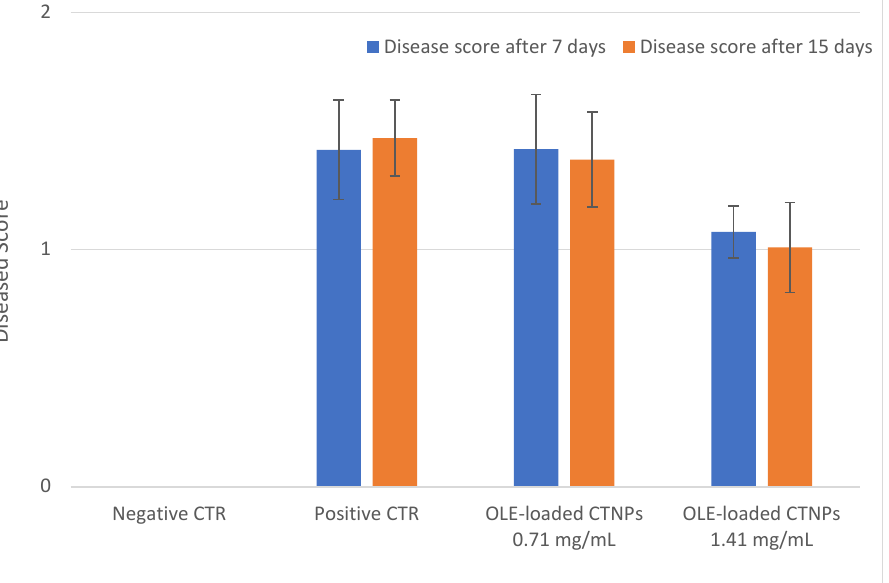
Figure 7. Symptoms of V. dahliae infections evaluated in seedlings of tomato at the three-leaf stage. Plants were scored at 7 (blue bars) and 15 (orange bars) days post-inoculation with the fungus. The results summarize the data for 10 plants per time point for each interaction.